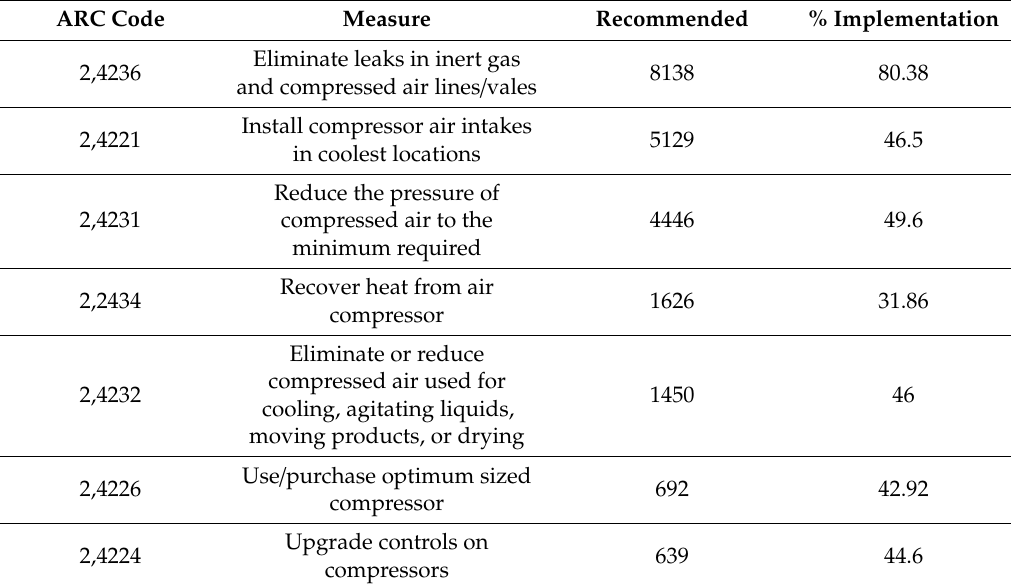
Table 8. Synoptic of the most recommended EEMs [142] that will be analyzed for the framework